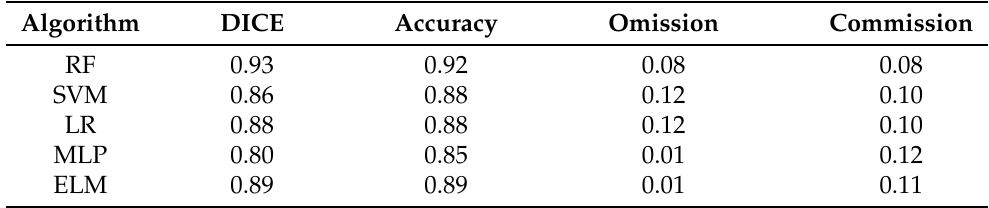
Table 4. Best model performance for the POST dataset applied over the Test